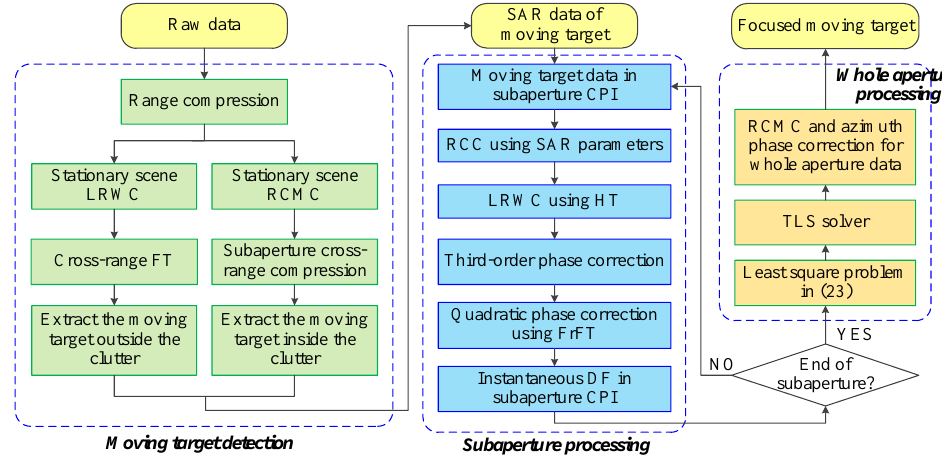
Figure 3. Flowchart of the proposed HPC-GMTIm algorithm.